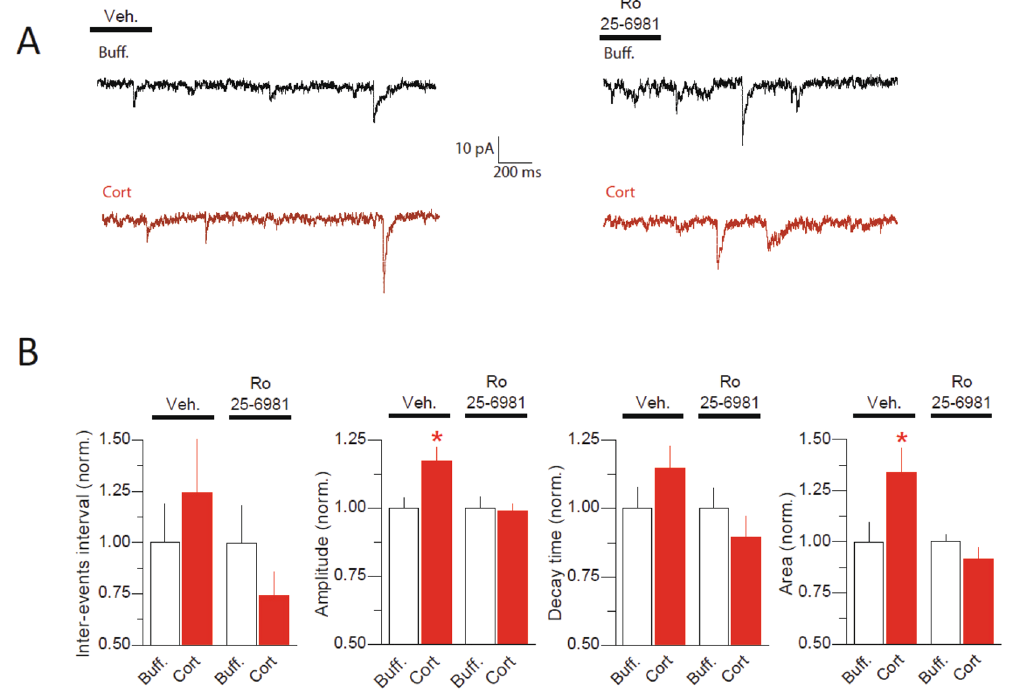
Figure 2. Corticosterone increases amplitude and charged area of NMDAR-mediated mEPSCs. ( A ) Representative traces of NMDAR mEPSCs after vehicle ( < 0.1% ethanol) and corticosterone (100 nM), in the presence or absence of Ro25–6981. Scale bar: horizontal 200 ms, vertical 10 pA. ( B ) Comparison of the inter- event interval, amplitude, decay time and area of NMDAR mEPSCs. mEPSCs were recorded in buffer without (vehicle, n = 14 cells) and with corticosterone (n = 19 cells, red bars). In a separate series of experiments, NMDAR mEPSCs were recorded in the presence of Ro 25–6981 (3 μ M, n = 9 cells) or Ro 25–6981 (3 μ M) plus corticosterone (100 nM) (n = 7 neurons). * p < 0.05, unpaired Student t